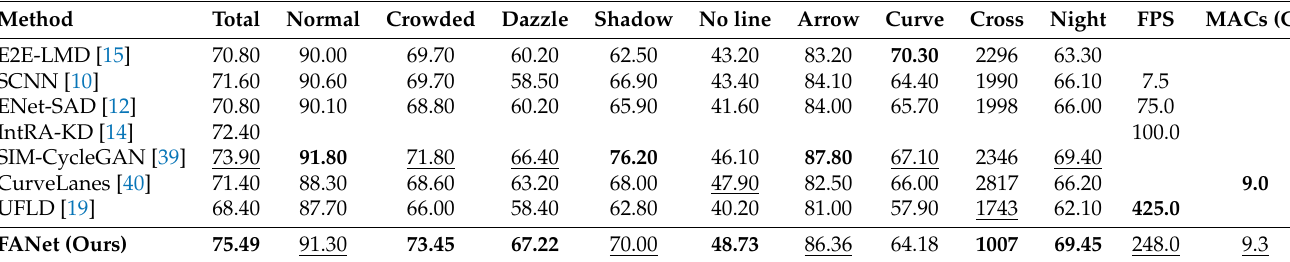
Table 4. State-of-the-art comparisons on CULane. For fair comparison, frames per second (FPS) was measured on the same machine used by our method. Because the images in “Cross” scene have no lanes, only false positives are shown. The best and second-best results across methods are shown in boldface and underlined, respectively. These blank values indicate that the results are not published in their papers, and their codes and models are not available